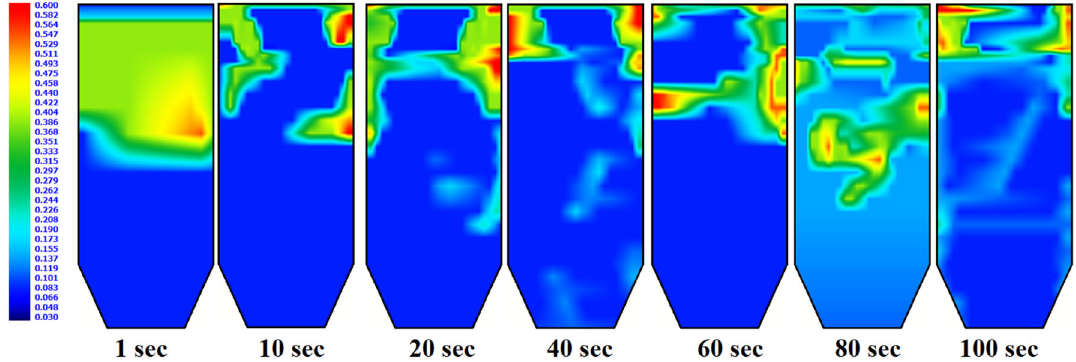
Fig. 3 Simulated results of solid volume fraction as function in time for the gas-particle flow in the upper part of the fuel